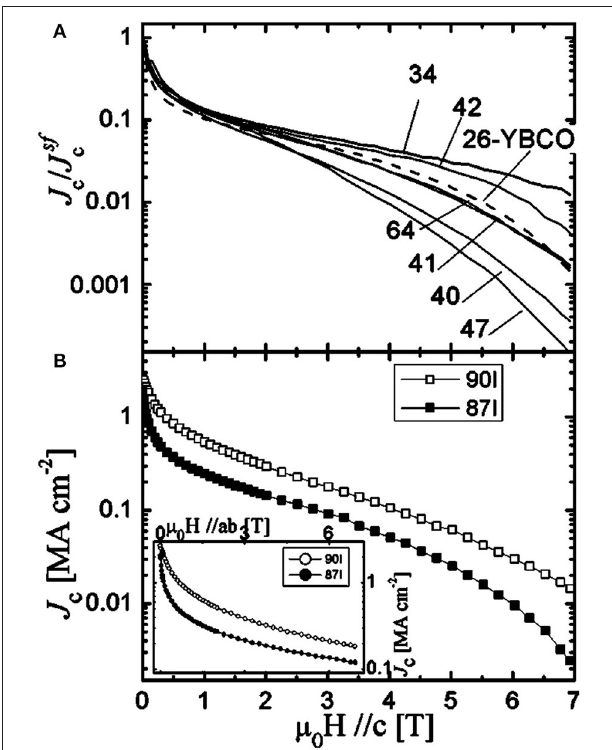
FIGURE 5 | Variation of J c with applied magnetic field at 75.5K for RE BCO thin films of various rare-earth combinations in ( RE 1: RE 2: RE 3) 1 Ba 2 Cu 3 O 7 (A) Normalized J c vs. applied field when applied field is along the c- axis. While sample number 26 refers to pristine YBCO, sample numbers 34, 40, 41, 42, 47, and 64 have RE 1: RE 2: RE 3 ratios as (Y:Sm